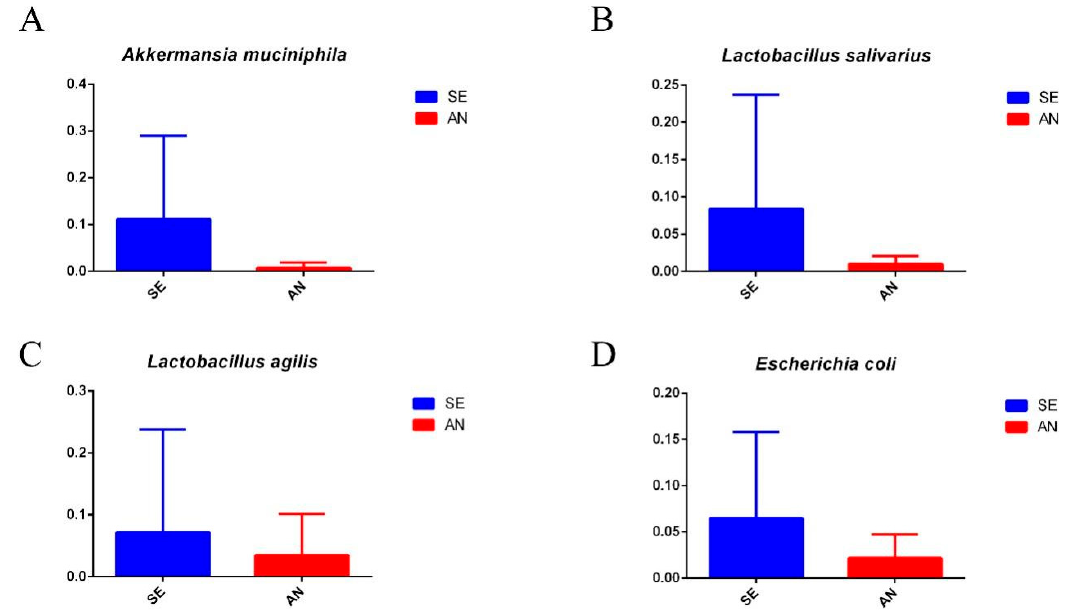
Figure 8. Relative abundance of the Akkermansia muciniphila bacterial species ( A ), Lactobacillus salivarius bacterial species ( B ), Lactobacillus agilis bacterial species ( C ), and Escherichia coli bacterial species ( D ) between the AN and SE samples.